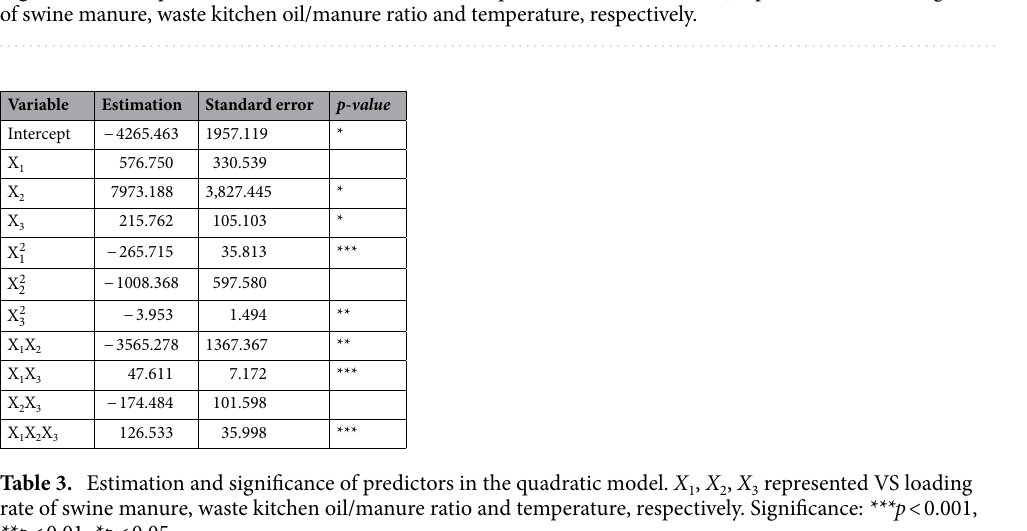
Figure 2. The importance score of each variable in the quadratic model. X 1 , X 2 , X 3 represented VS loading rate of swine manure, waste kitchen oil/manure ratio and temperature, respectively.